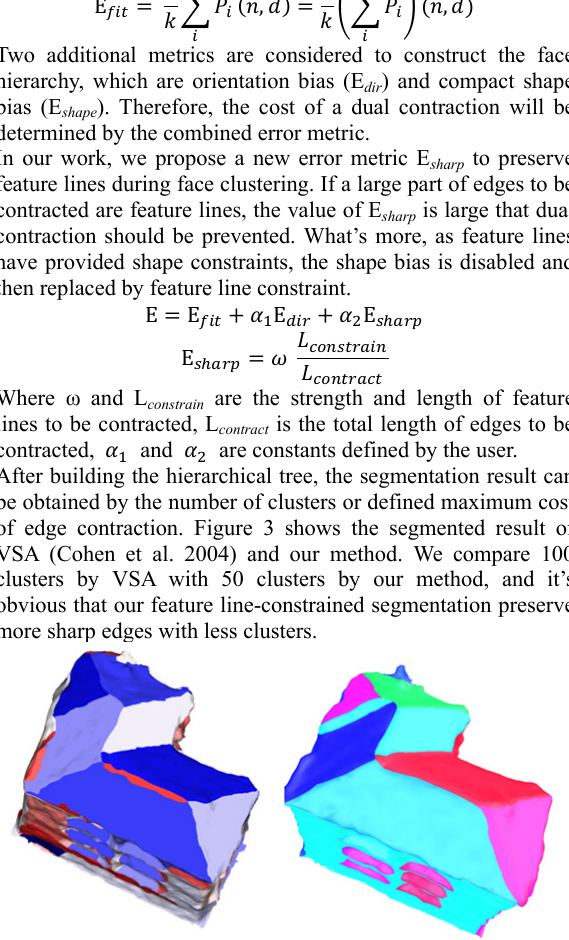
Fig.3. Left: 100 clusters by VSA. Right: 50 clusters by our